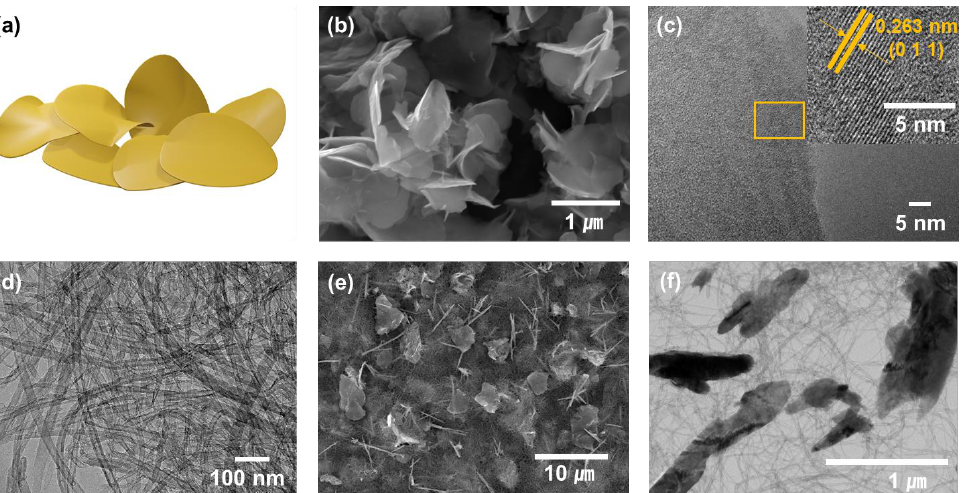
Figure 1. Morphological characterization of the VSe 2 , MWCNT, VSe 2 @MWCNT. ( a ) Illustration of flake-like VSe 2 , ( b ) SEM image of VSe 2 , ( c ) HRTEM of VSe 2 . ( d ) TEM image of MWCNT. ( e ) SEM image, ( f ) TEM image of VSe 2 @MWCNT.